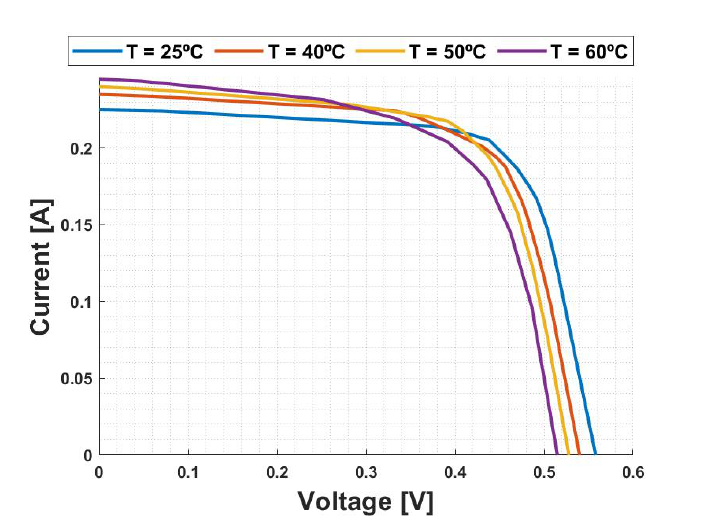
Figure 14. Summary of the I-V curves obtained with the d1MxP model for different temperatures.